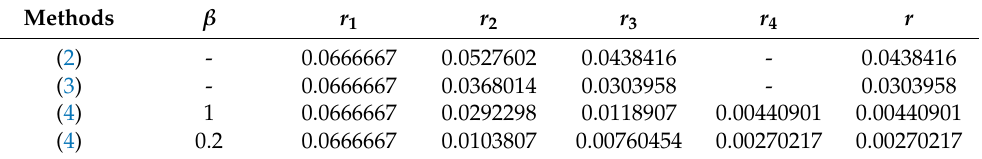
Table 5. Radii of convergence for Example 5.